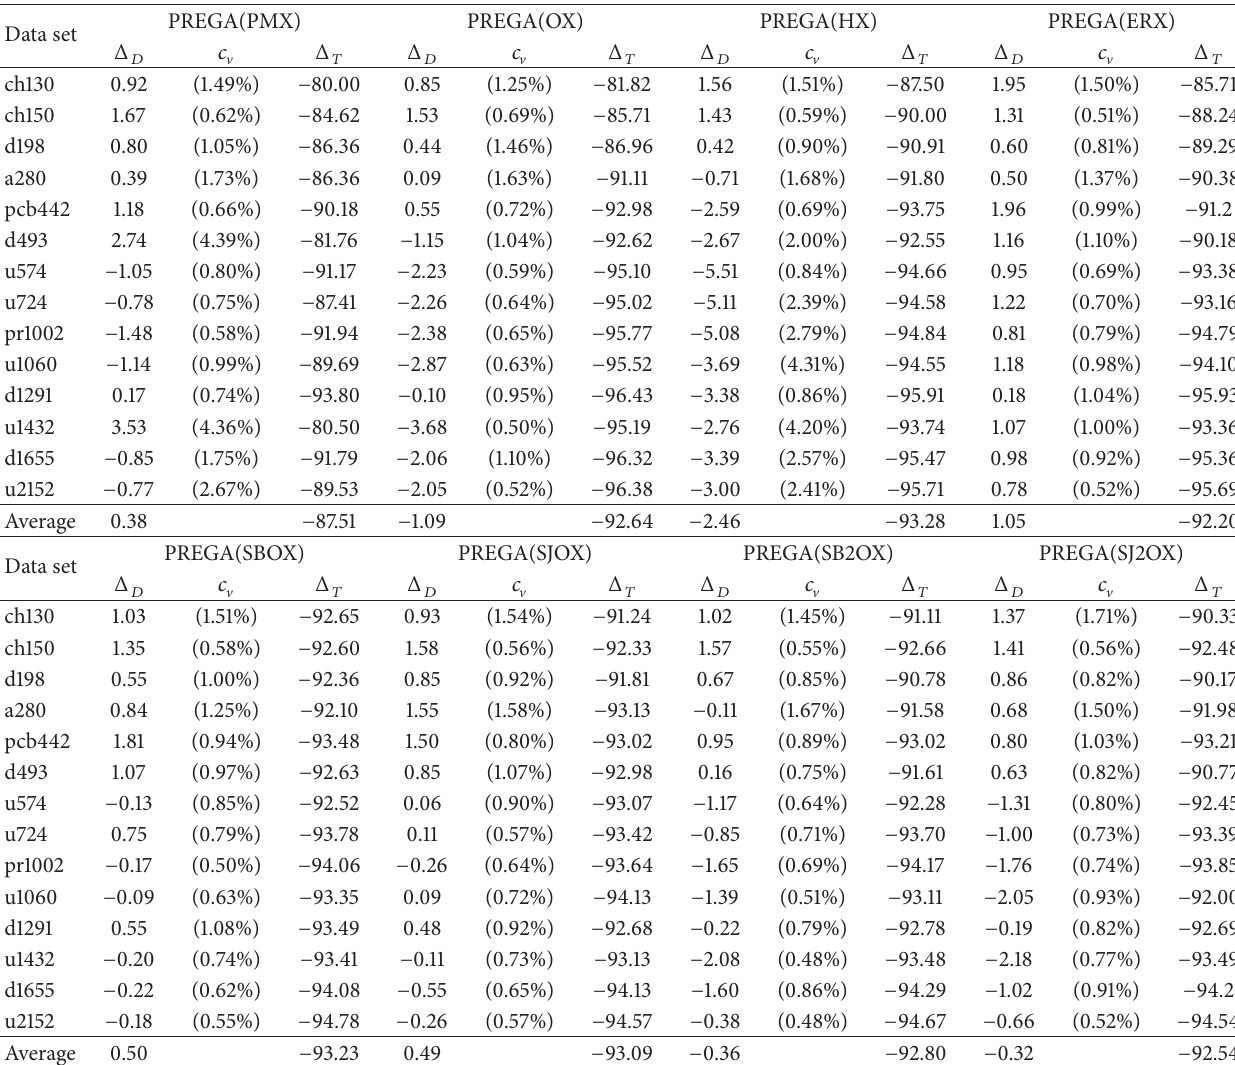
Table 2: Simulation results of using different crossover